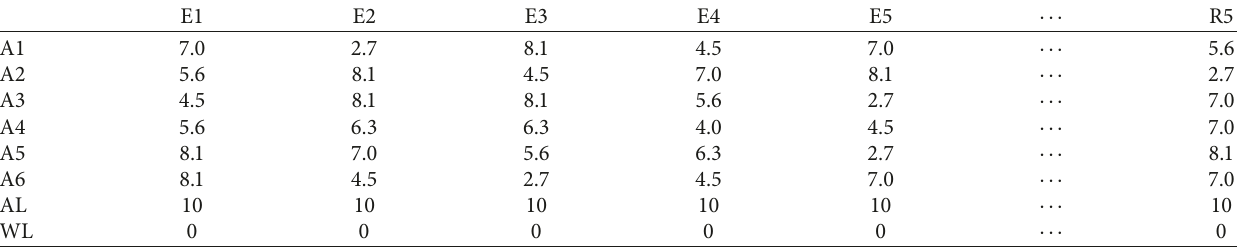
Table 14: The initial assessment matrix of the neutrosophic TOPSIS.